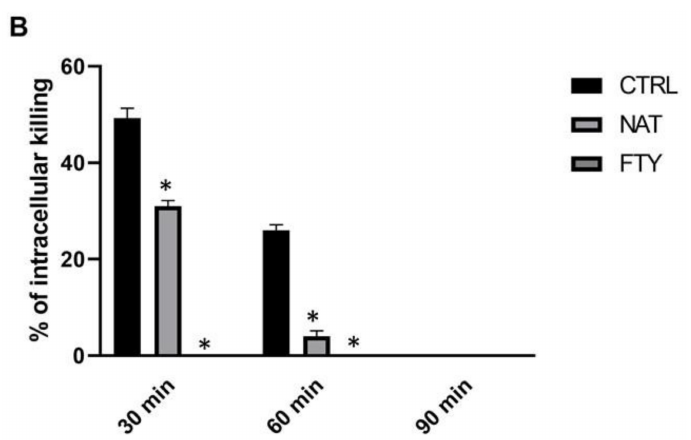
Figure 1. DMT treatment determined a reduction of intracellular K. pneumoniae killing. PMNs (10 6 cells / mL) were incubated for 60 min with the specific DMT ( A, first-line and B, second-line), then bacteria (10 7 CFU / mL) were added, and their killing activity was evaluated at T30, T60 and T90. Data are shown as killing percentages from at least three independent experiments. * p < 0.01 vs. DMTs-treated cells by using the Mann–Whitney test for nonparametric